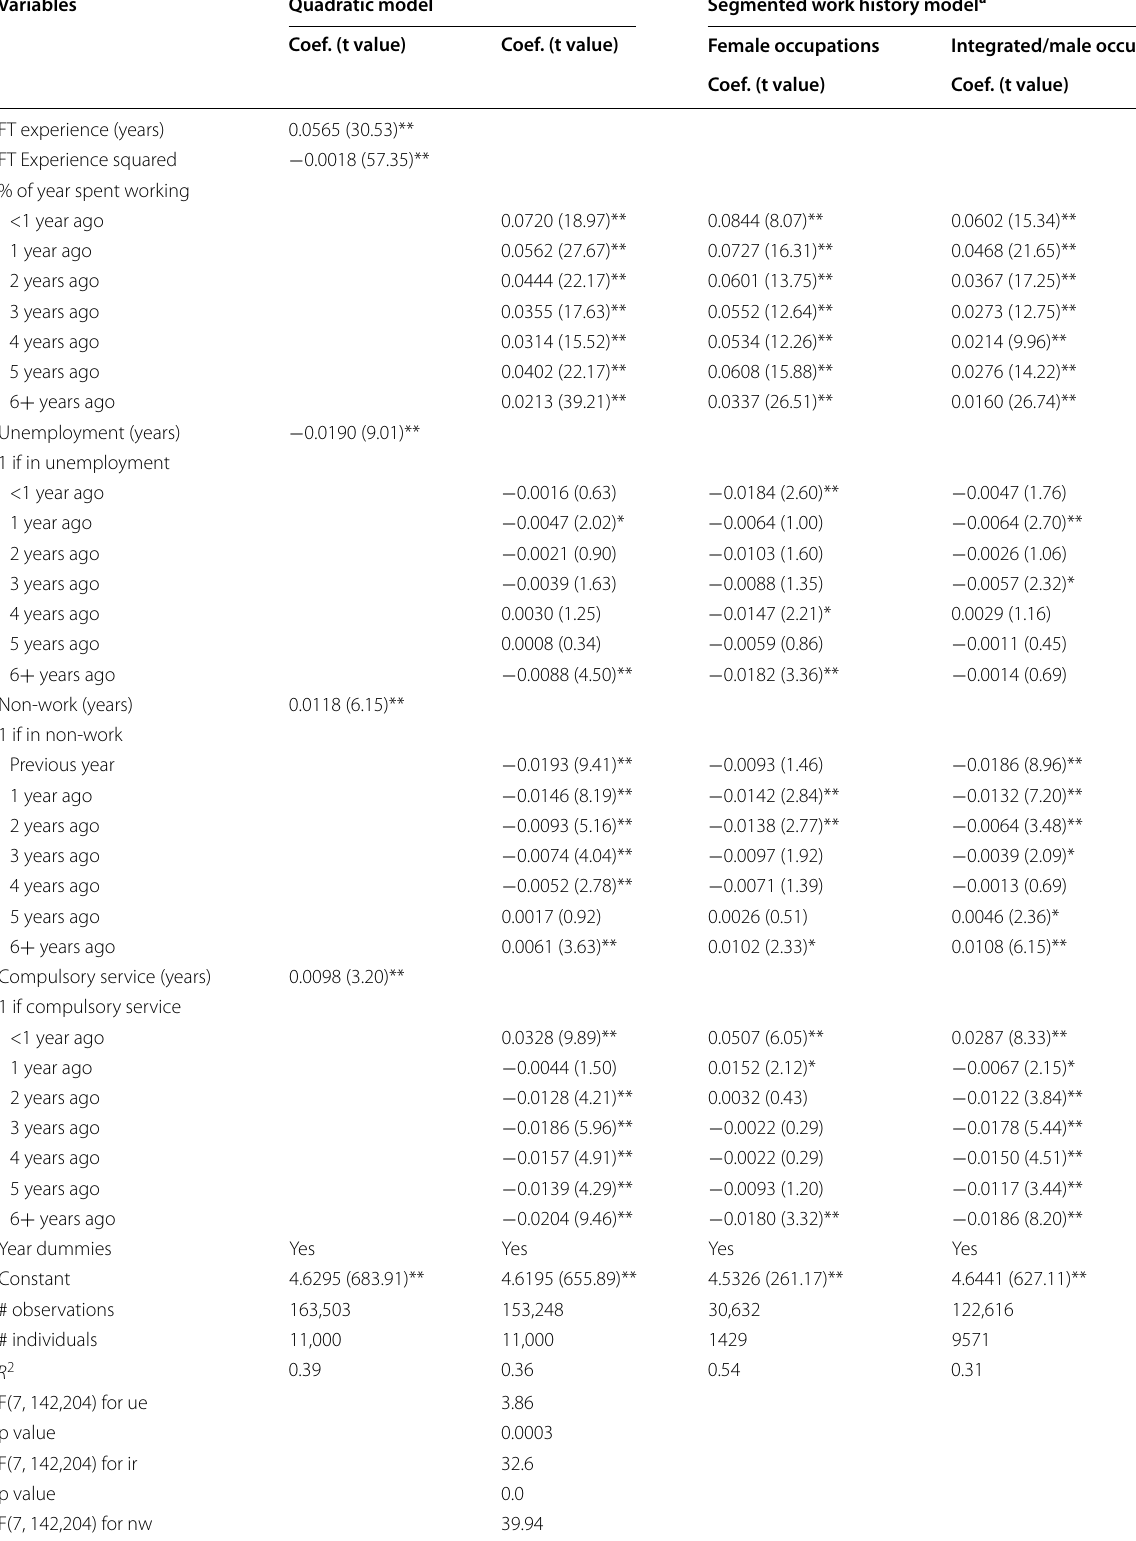
Table 3 Fixed effects estimates of wage equations, 1981–1997 IABS data male young